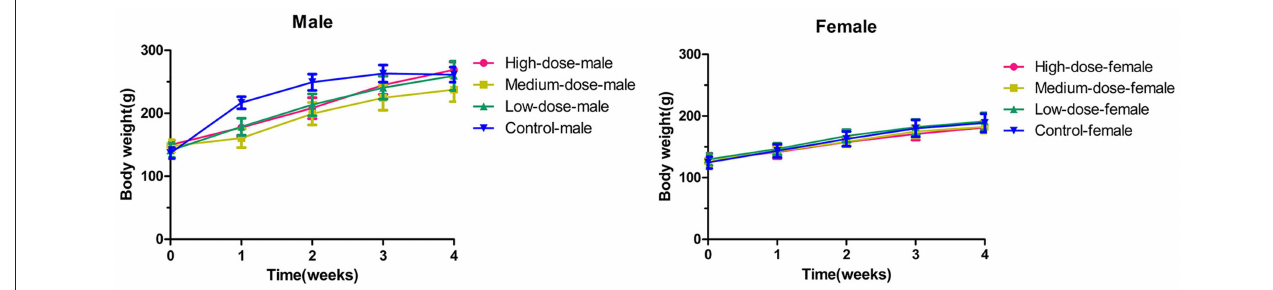
FIGURE 1 | The changes of body weight in rats during 28 days (4 weeks) with oxyclozanide treatment at 0 (control), 74 mg/kg BW/day (low dose), 185 mg/kg BW/day (medium dose), or 370 mg/kg BW/day (high dose)